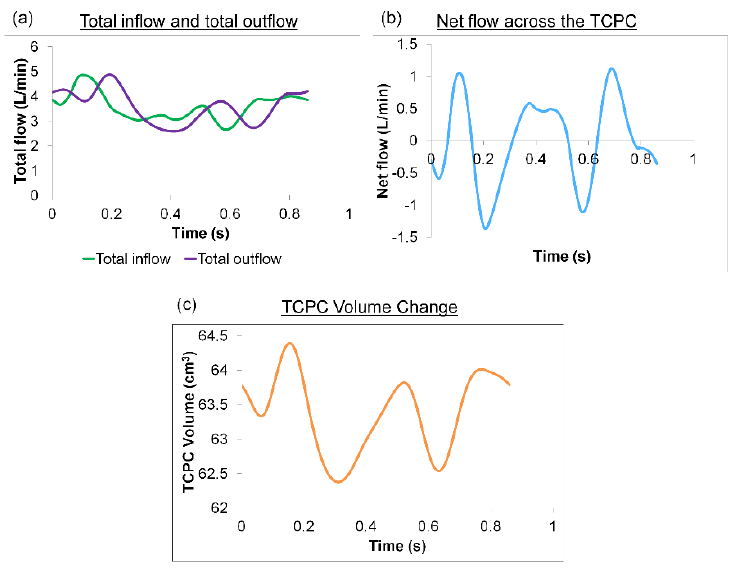
Figure 7. ( a ) Waveforms of the total inflow and outflow ( b ) Waveform of the net flow through the TCPC ( c ) Waveform of the TCPC volume throughout the cardiac cycle. TCPC: total cavopulmonary connection.